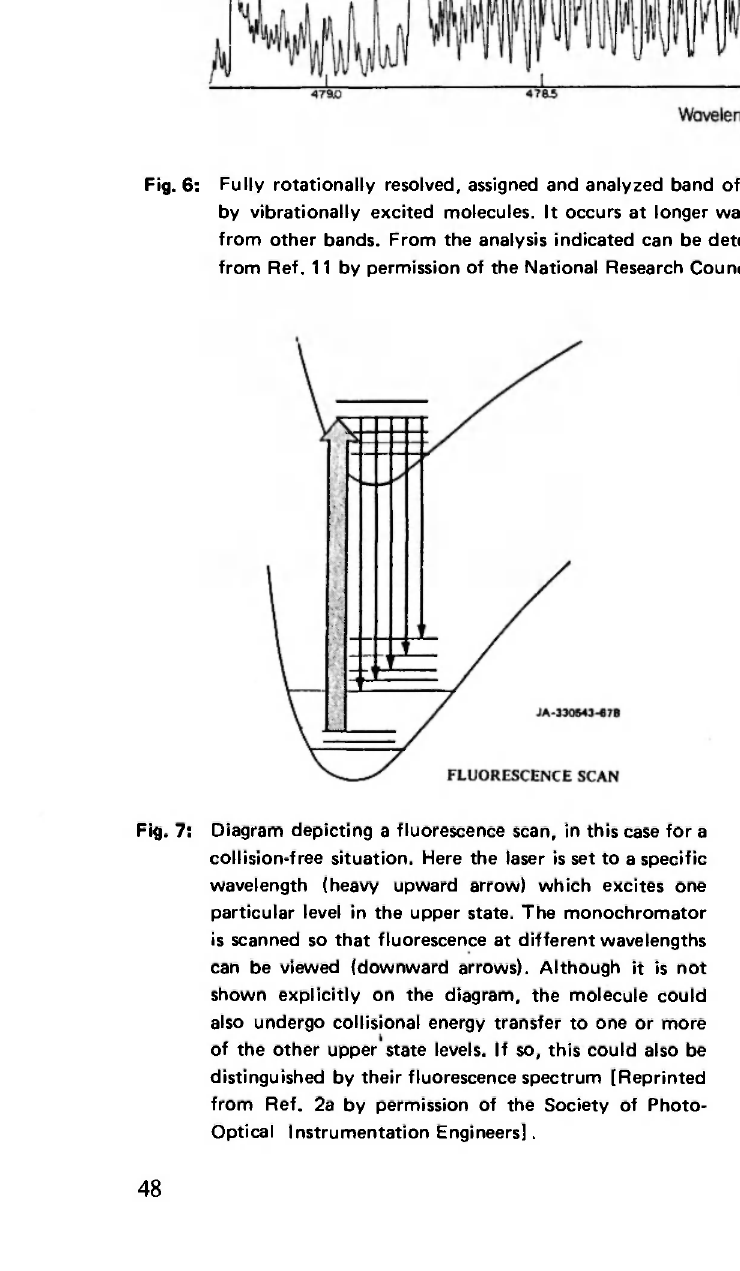
Fig. 7: Diagram depicting a fluorescence scan, in this case for a collision-free situation. Here the laser is set to a specific wavelength (heavy upward arrow) which excites one particular level in the upper state. The monochromator is scanned so that fluorescence at different wavelengths can be viewed (downward arrows). Although it is not shown explicitly on the diagram, the molecule could also undergo collisional energy transfer to one or more of the other upper state levels. If so, this could also be distinguished by their fluorescence spectrum [Reprinted from Ref. 2a by permission of the Society of Photo- Optical Instrumentation